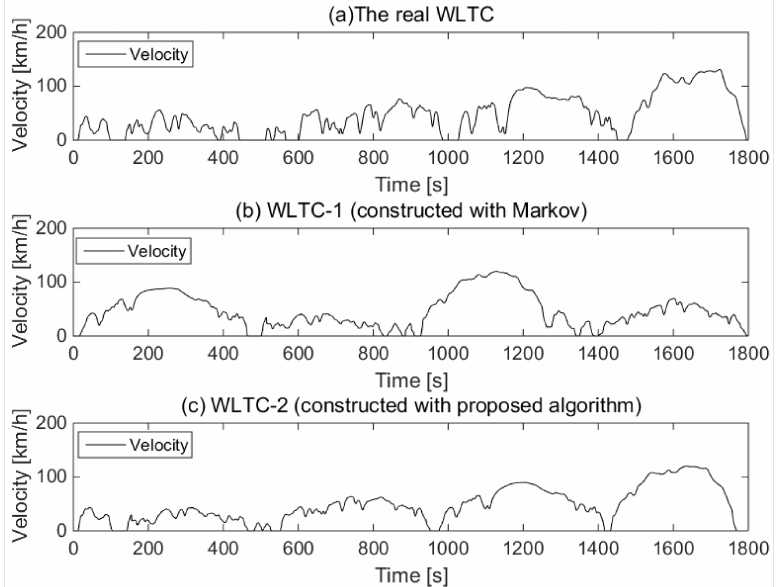
Figure 17. Comparisons of three kinds of